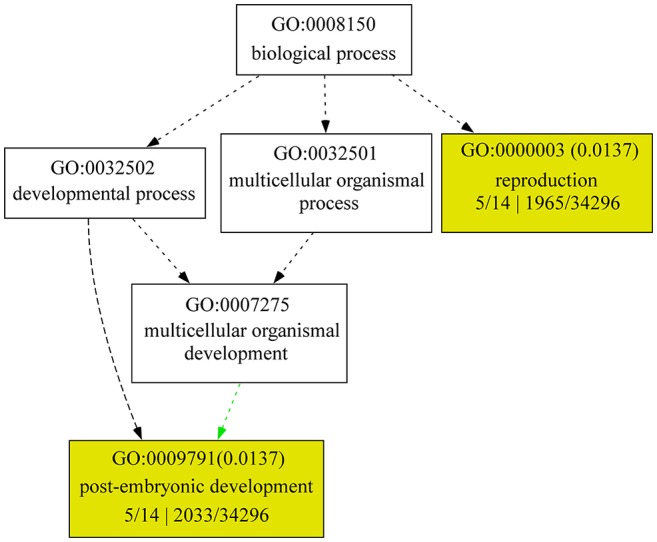
GO enrichment analysis for changed proteins. GO terms, such as “biological process,” “molecular function,” and “cellular component,” were identified using AGRIGO (http://bioinfo.cau.edu.cn/agriGO/index.php) with default significance levels (FDR < 0.05). 5/14 means gene number in input list; 1965/32496 and 2033/32496 means gene number in BG/Ref.